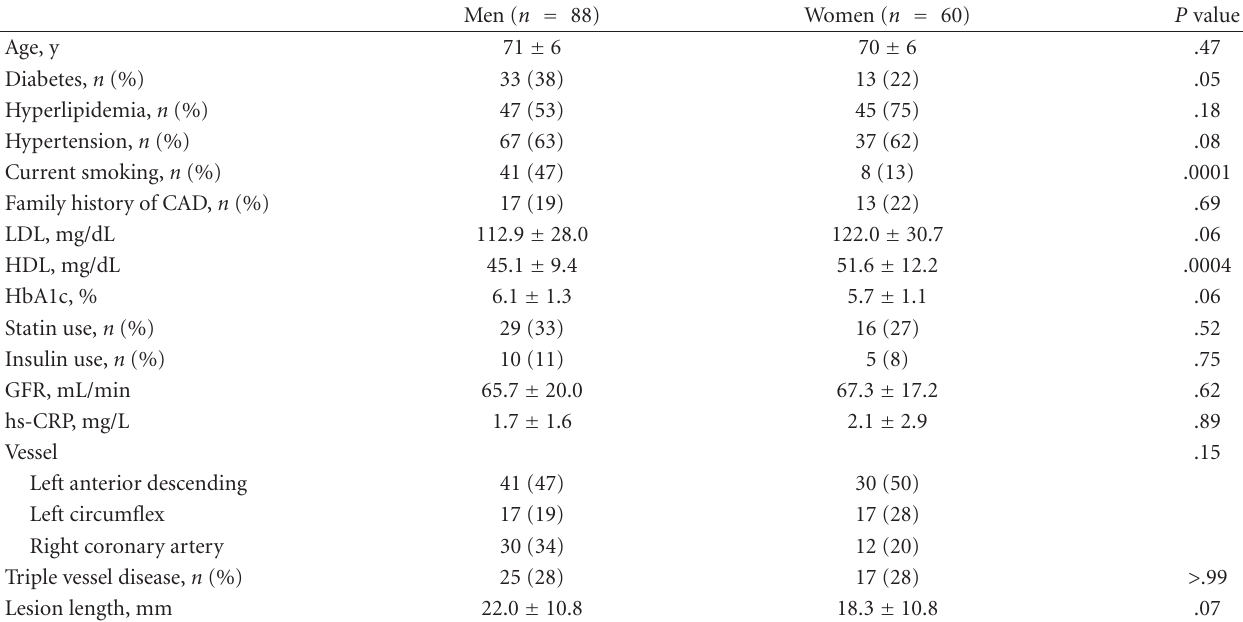
Table 1: Baseline clinical characteristics.